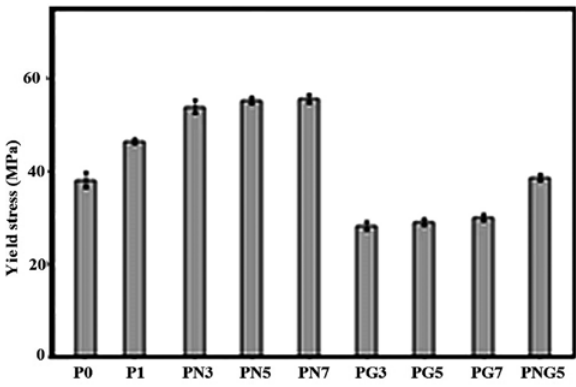
Figure 9: Tensile modulus of neat PA6 and PA6/PC/NBR blend with and without OC modifier and